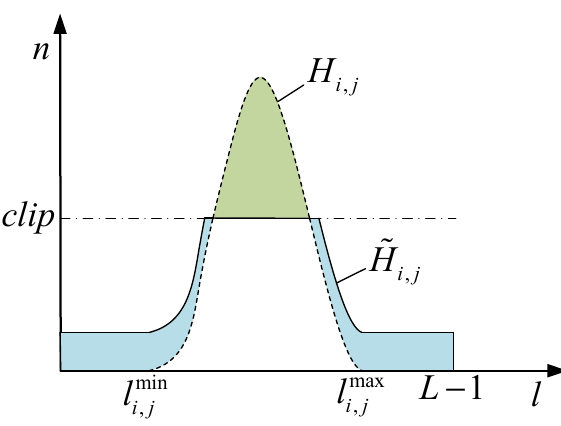
Figure 1. Histogram adjustment within sub-block (i,j).